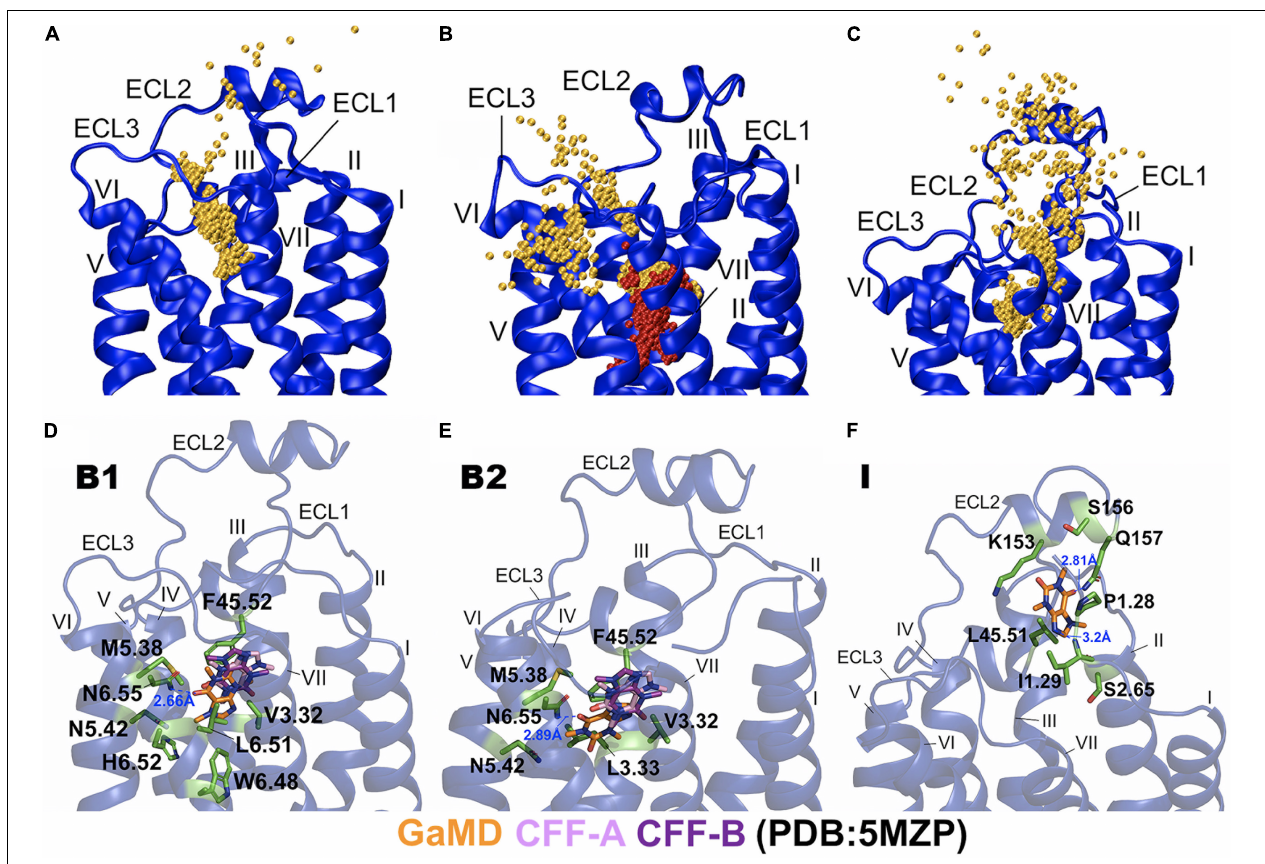
FIGURE 3 | Binding and dissociation pathways of caffeine (CFF) in the A 2A AR revealed from the Gaussian-accelerated molecular dynamics (GaMD) simulations. (A) Trace of CFF (orange) binding to the A 2A AR observed in the GaMD equilibration. Starting from free diffusion in the solvent, CFF bound to the orthosteric site of the A 2A AR receptor. (B) Binding of the second CFF (orange) to orthosteric pocket of the A 2A AR observed in GaMD Sim2. The first bound CFF is shown in red. (C) Pathway of CFF that dissociated from orthosteric site of the A 2A AR to the bulk solvent observed in GaMD Sim3. The A 2A AR receptor is shown in blue ribbons and the CFF traces are shown as orange beads. (D) The B1-bound conformational state of CFF was located between ECL2, TM3, TM5, and TM6 with interacting residues F45.52 ECL2 , V3.32, M5.38, N5.42, W6.48, L6.51, H6.52, and N6.55. (E) The B2-bound conformational state of CFF was located between ECL2, TM3, TM5, and TM6 with interacting residues V3.32, L3.33, F45.52 ECL2 , M5.38, N5.42, and N6.55. CFF formed a hydrogen bond with the receptor residue N6.55 in both the B1 and B2 states. (F) The intermediate (I) conformational state of CFF that was located between ECL2, N-terminus of TM1, and TM2 with interacting residues P1.28, I1.29, S2.65, K153 ECL2 , S156 ECL2 , Q157 ECL2 , and L45.51 ECL2 . CFF formed hydrogen bonds with both receptor residues I1.29 and Q157 ECL2 . The CFF ligand is represented by sticks with carbon atoms colored in orange for simulation-derived low-energy conformations and pink and purple for two x-ray conformations in the 5MZP PDB structure. The receptor-interacting residues are highlighted in